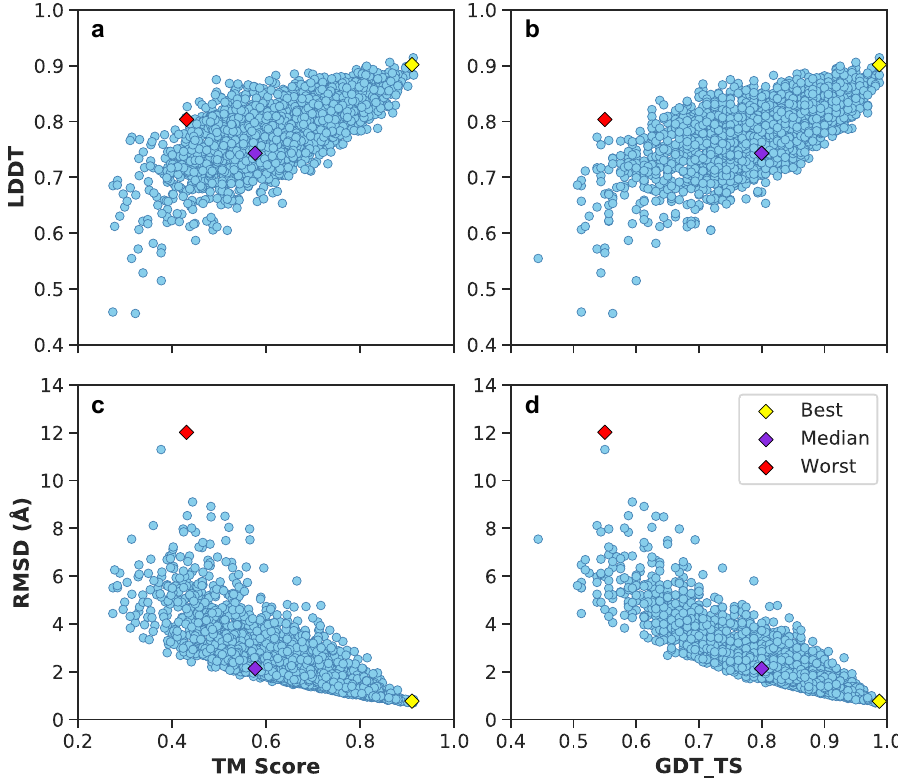
Figure 11. Juxtaposition of 3D structural metrics of the combined validation-test set: TM score, LDDT, GDT_TS, and RMSD. In addition, best, median, and worst predictions are shown based on PIDs. ( a ) LDDT vs. TM score metrics of the validation-test set. ( b ) LDDT vs. GDT_TS score metrics of the validation-test set. ( c ) RMSD vs. TM score metrics of the validation-test set. ( d ) RMSD vs. GTD_TS score metrics of the validation-test set.